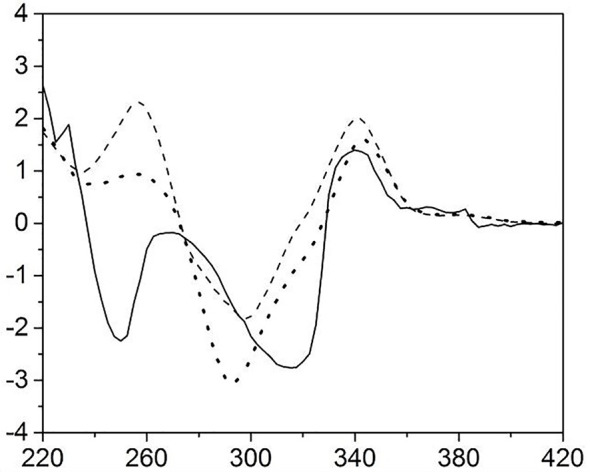
Comparison of the ECD spectra of (-)-(S)-1 (dashed line), (-)-(S)-2 (dotted line), and (-)-(S)-flavanone (continuous line).